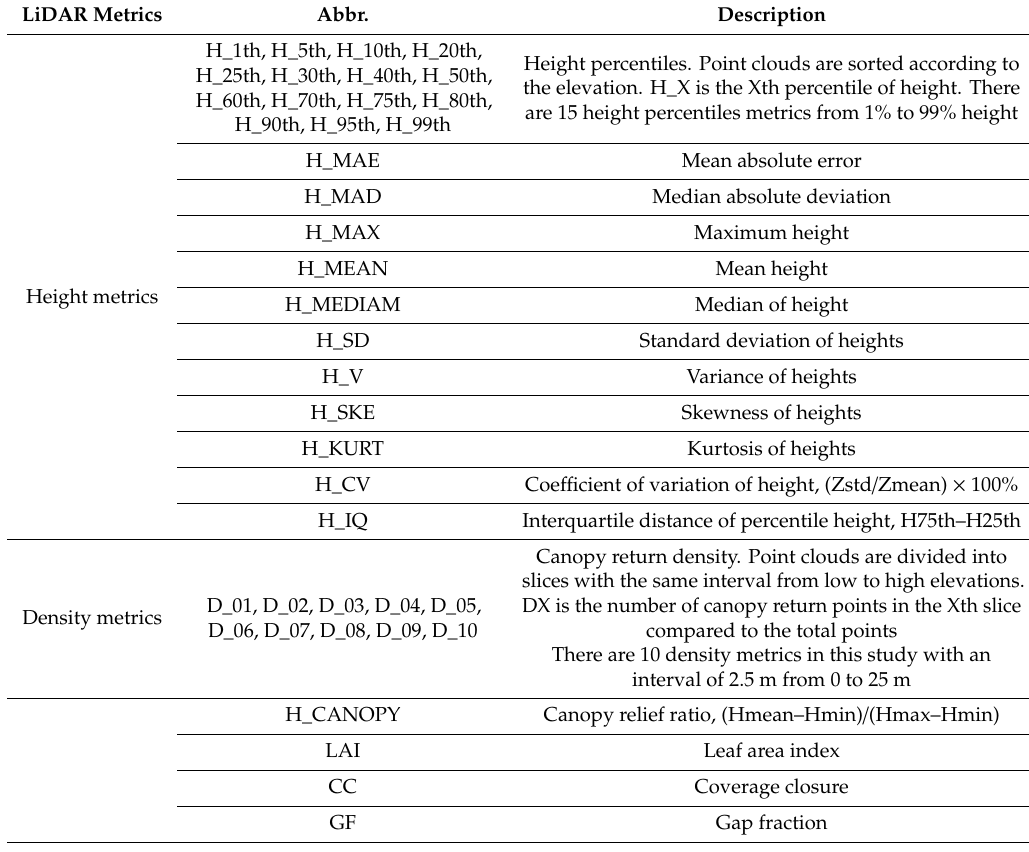
Table 3. Metrics calculated from light detection and ranging (LiDAR) data and their corresponding abbreviations.